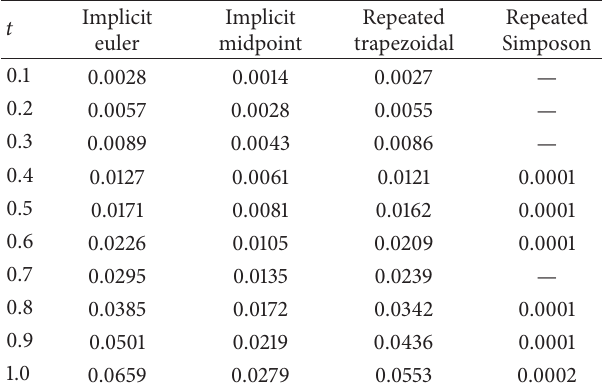
Table 2: Absolute errors in the solution of (57) when ℎ = 0.01 .